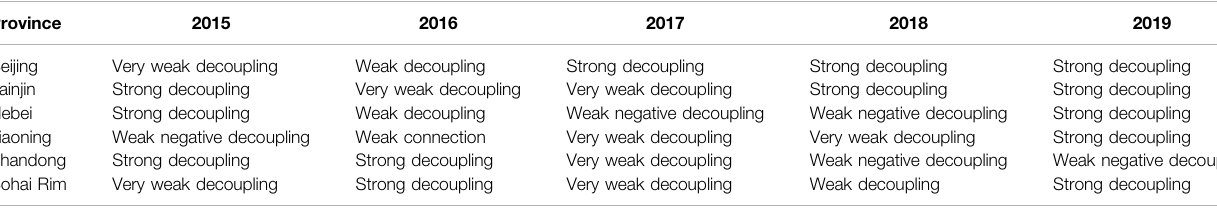
TABLE 3 | Decoupling situation of the Bohai Rim.